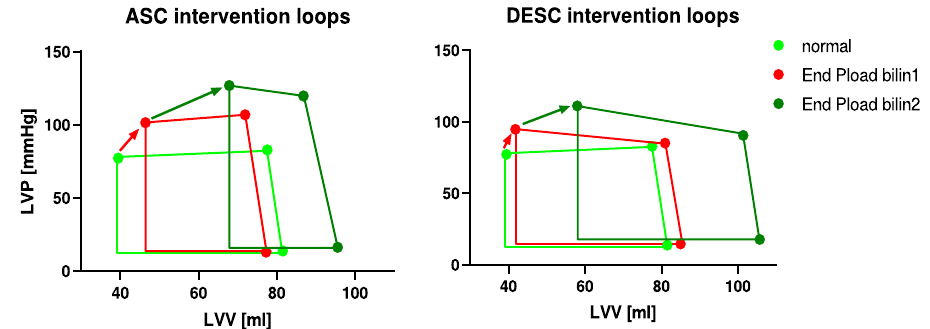
Figure 7. Mean volume and pressure values of all animals before intervention (normal), at the end of the first phase of the pressure intervention (End PLoad bilin1) and at the end of the second phase of the pressure intervention (PLoad bilin2). The results for the ascending aorta interventions (ASC) and for the descending aorta intervention (DESC) are shown